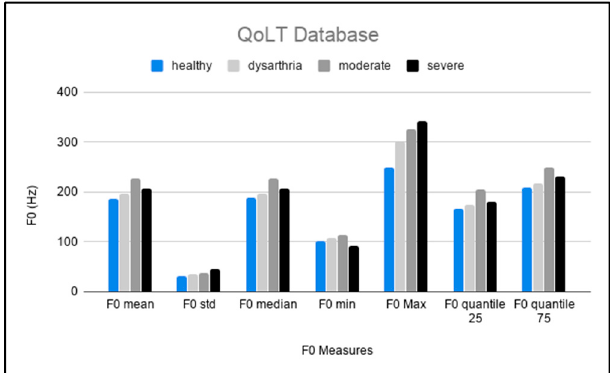
Figure 3. The mean values of all F0 measurements from the QoLT dataset.